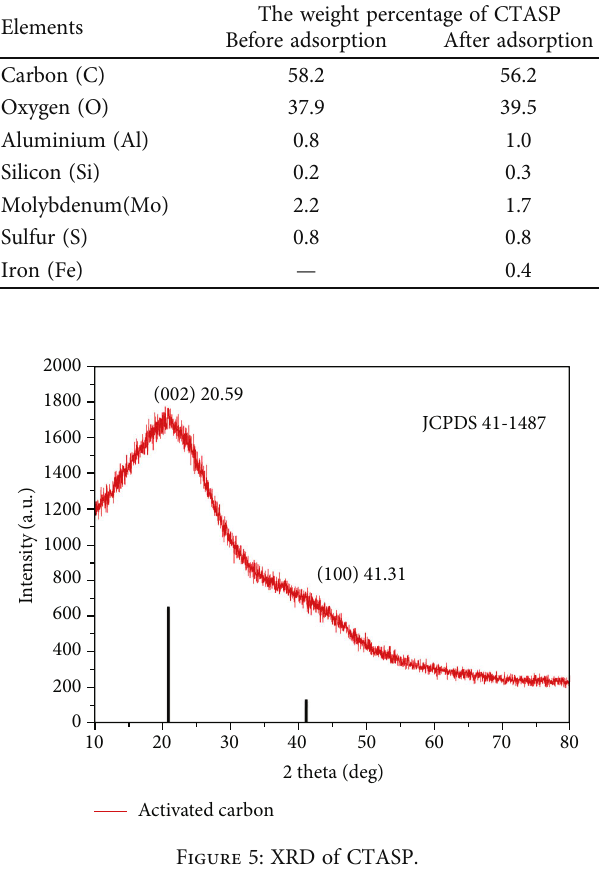
Figure 5: XRD of